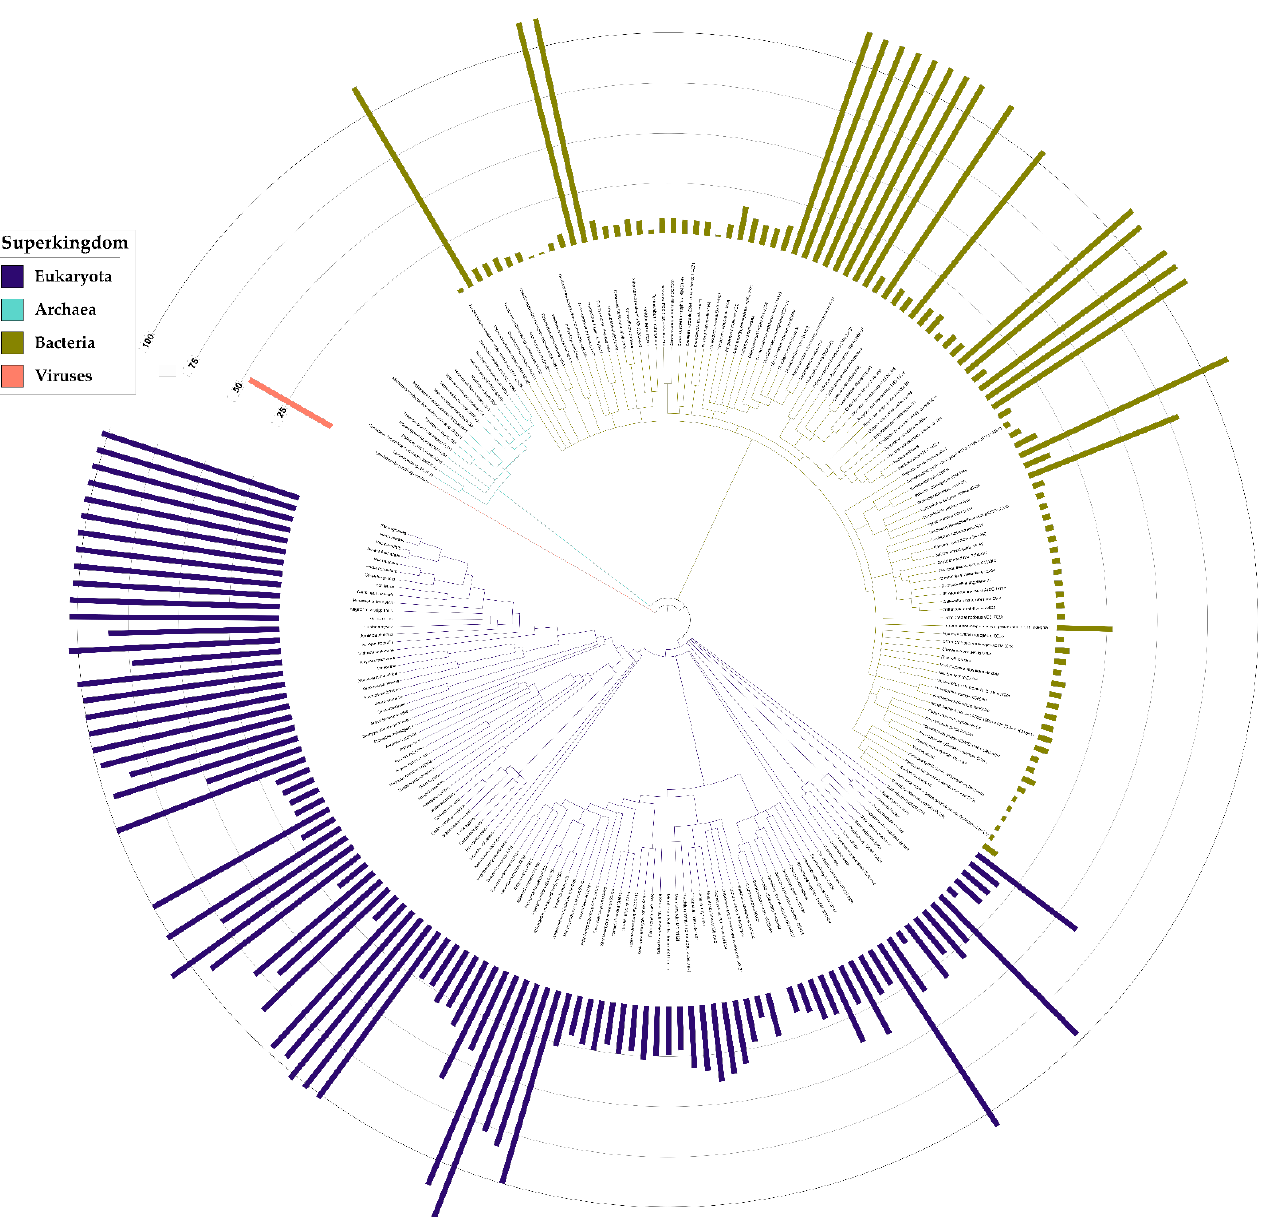
Figure 3. Inserted domain lengths across model taxa. The lengths of inserted domains were measured for each homolog. The sequences (organisms listed in Data Table S4) were aligned per superkingdom for delimiting domains, which then allowed for the measurement of each inserted region (if present). An evolutionary tree was generated using PhyloT and iToL, and was mapped with the lengths of inserted domains within each respective homolog. For all inserted domain lengths measured, these data were used to generate Figure S5, a histogram illustrating counts by ranges of domain lengths per superkingdom.